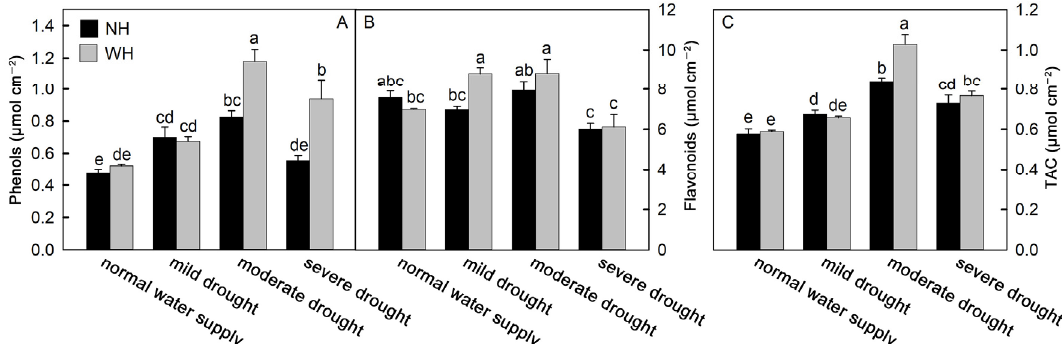
Figure 5. Difference of phenolic and flavonoid contents and total antioxidant capacity. Effects of water and host on content of phenols ( A ) and flavonoids ( B ), and total antioxidant capacity (TAC, ( C )) of S. album seedling leaves (means ± SE, n = 5). NH, grown without host; WH, grown with host. Different letters above bars indicate statistical significance ( p < 0.05).